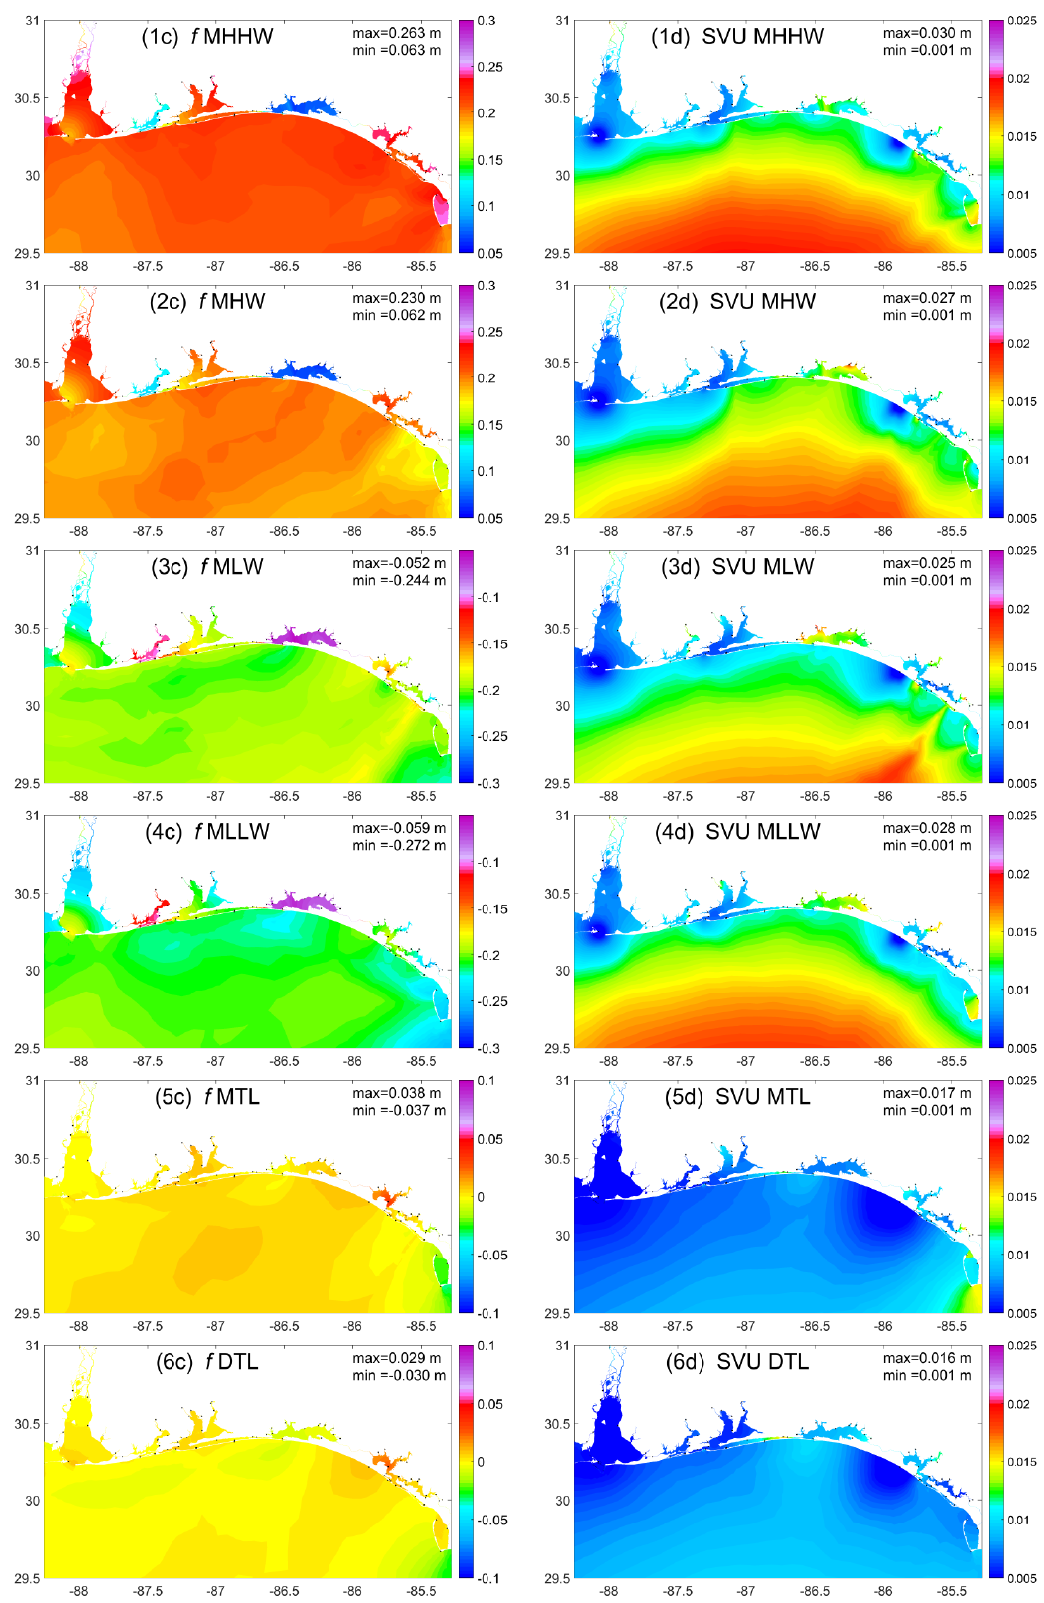
Figure 9. Datums products f and associated spatially varying uncertainty Pa in ( a , b ) computational domain and ( c , d ) VDatum region. Rows ( 1 – 6 ) are the six datums, MHHW, MHW, MLW, MLLW, MTL, and diurnal tide level (DTL), respectively.